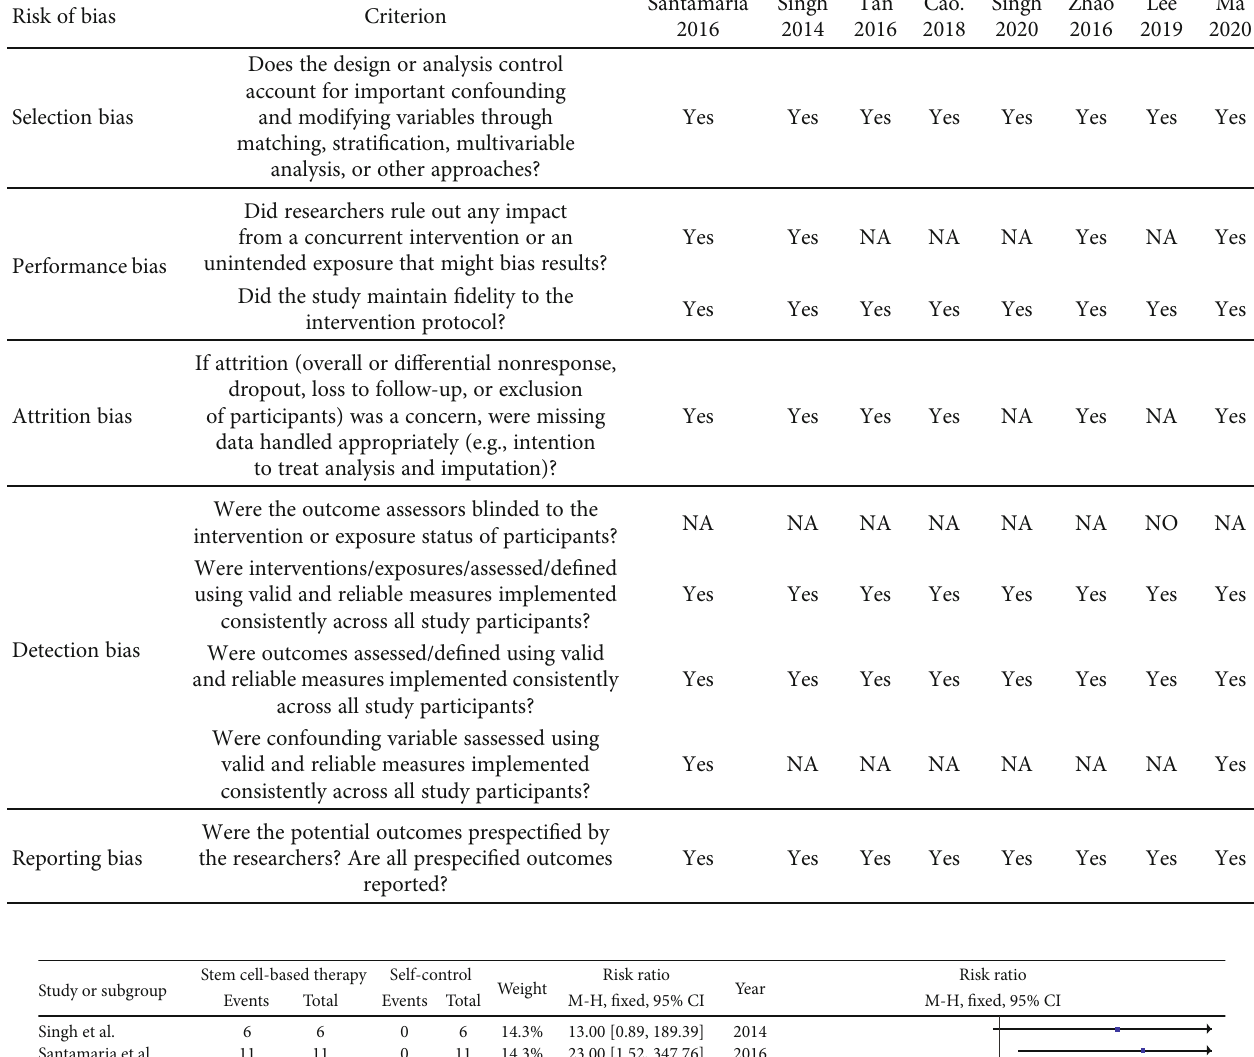
Table 3: Checklist for quality assessment of the case series study.